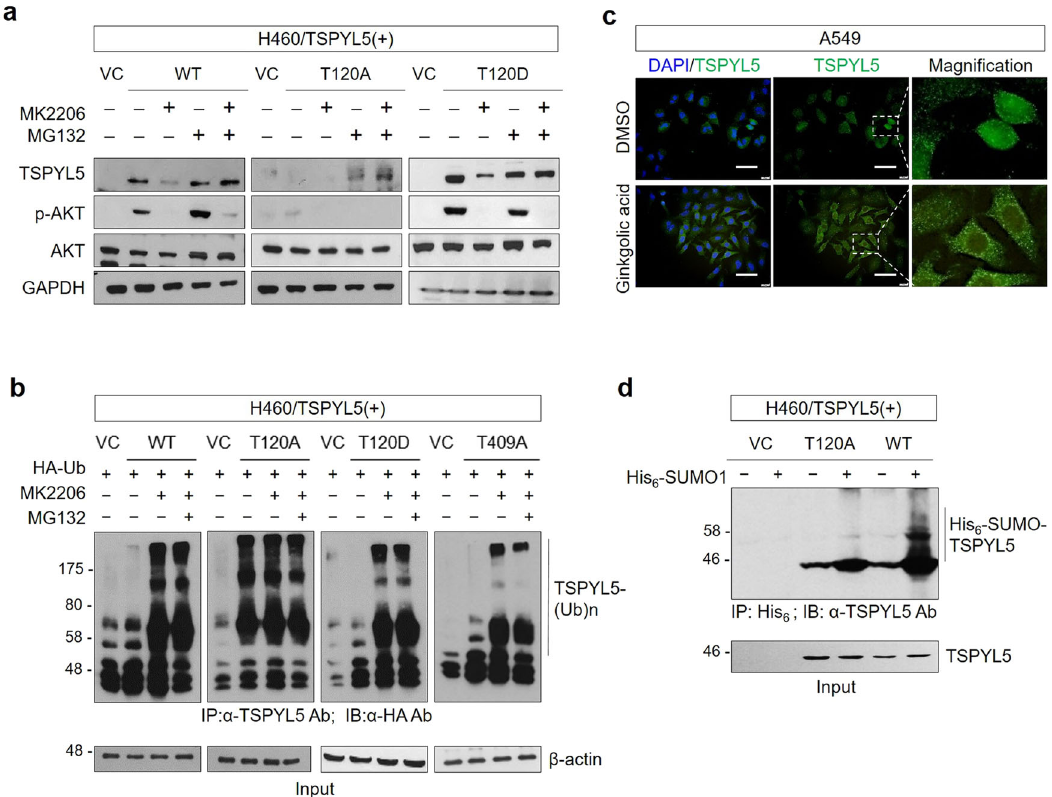
Fig. 6 AKT-mediated phosphorylation of threonine-120 in TSPYL5 blocks ubiquitination and induces SUMOylation. a The effect of AKT inhibitor (MK2206) or 26S proteasomal inhibitor MG132 on TSPYL5 expression in H460 cells transfected with TSPYL5 (WT, mutant T120A or T120D). VC: pcDNA3.1-transfected control. The activity of AKT inhibitor was con fi rmed by Western blot analysis of p-AKT. b In vivo ubiquitination assay of H460 cells transfected with HA ubiquitin and TSPYL5 or related mutants (T120A, T120D, and T409A) and treated with or without MK2206. Cells were lysed and immunoprecipitated with anti-TSPYL5 antibody. Ubiquitinated TSPYL5 was determined with anti-HA antibody. c Treatment of A549 cells with the SUMO1 modi fi cation inhibitor ginkgolic acid inhibited nuclear translocation of TSPYL5. A549 cells attached on coverslips were treated with ginkgolic acid (3 μ M, 4 h), and intracellular staining of TSPYL5 was performed after fi xation and permeabilization. Scale bar: 20 μ m. d In vivo SUMOylation assay of H460 cells transfected with His 6 -SUMO1 and TSPYL5 or related mutants T120A. Cell lysates were precipitated with Ni-agarose bead and Western blot analysis was performed with anti-TSPYL5